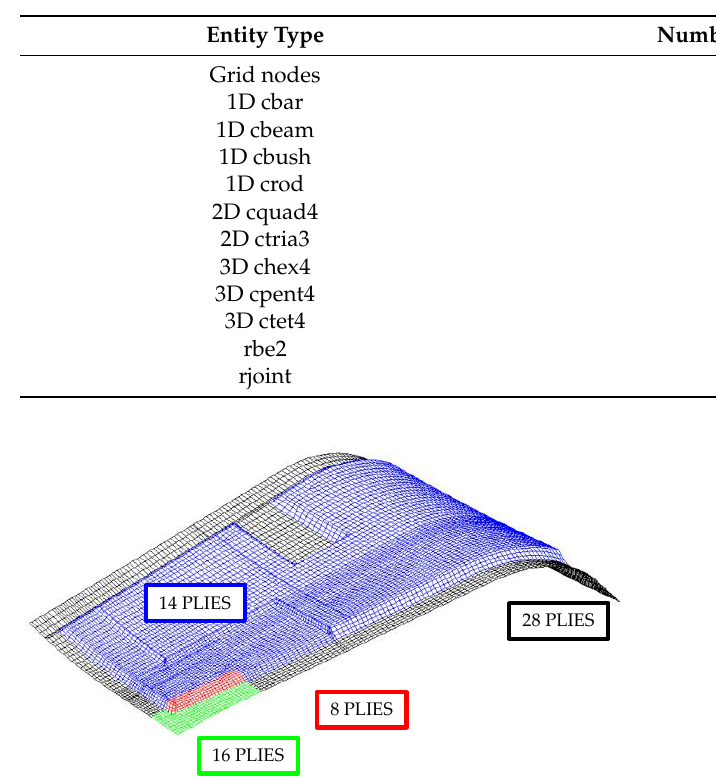
Table 1. FE model data.